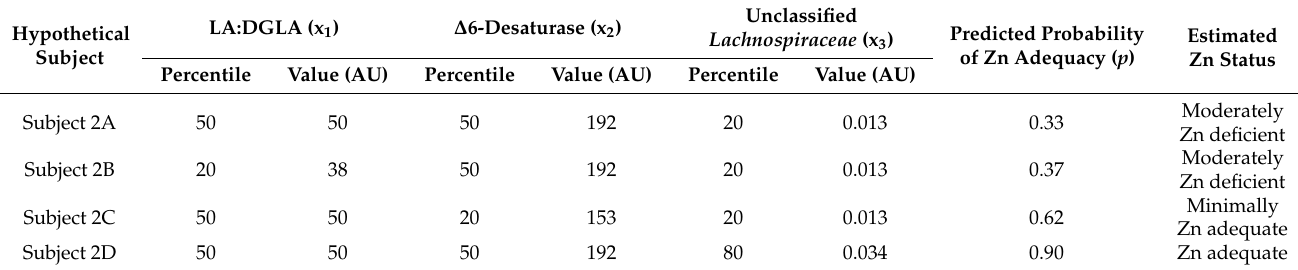
Table 7. Predicted probability of Zn adequacy of hypothetical subjects using the above ZSI example 2 1 .